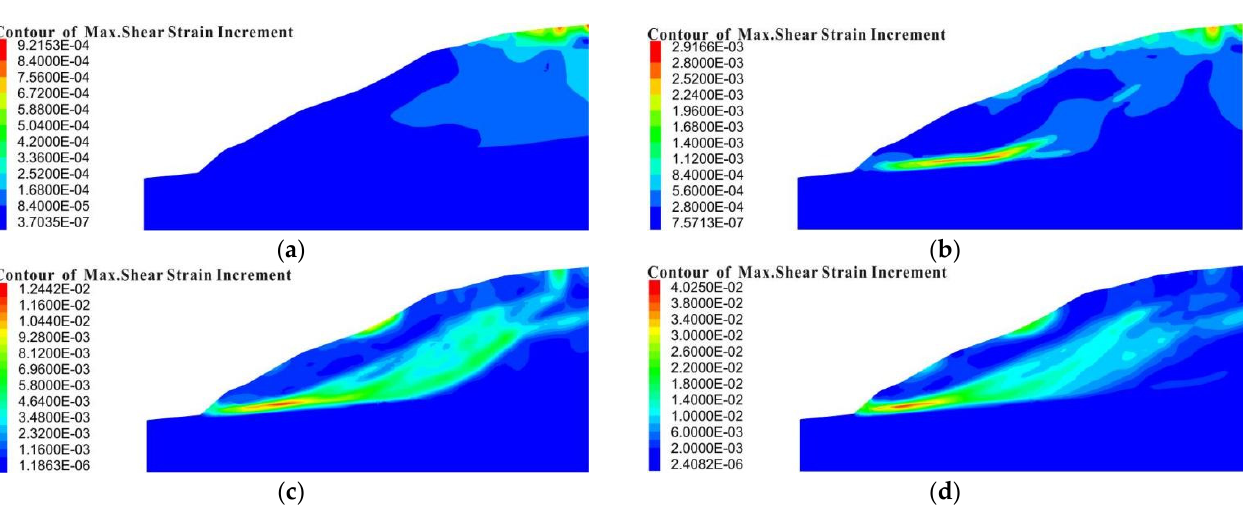
Figure 17. Increment of shear strain in the model slope with an HADAFZ at input PGA of ( a ) a = 0.1 g, ( b ) a = 0.2 g, ( c ) a = 0.3 g, and ( d ) a = 0.4 g.